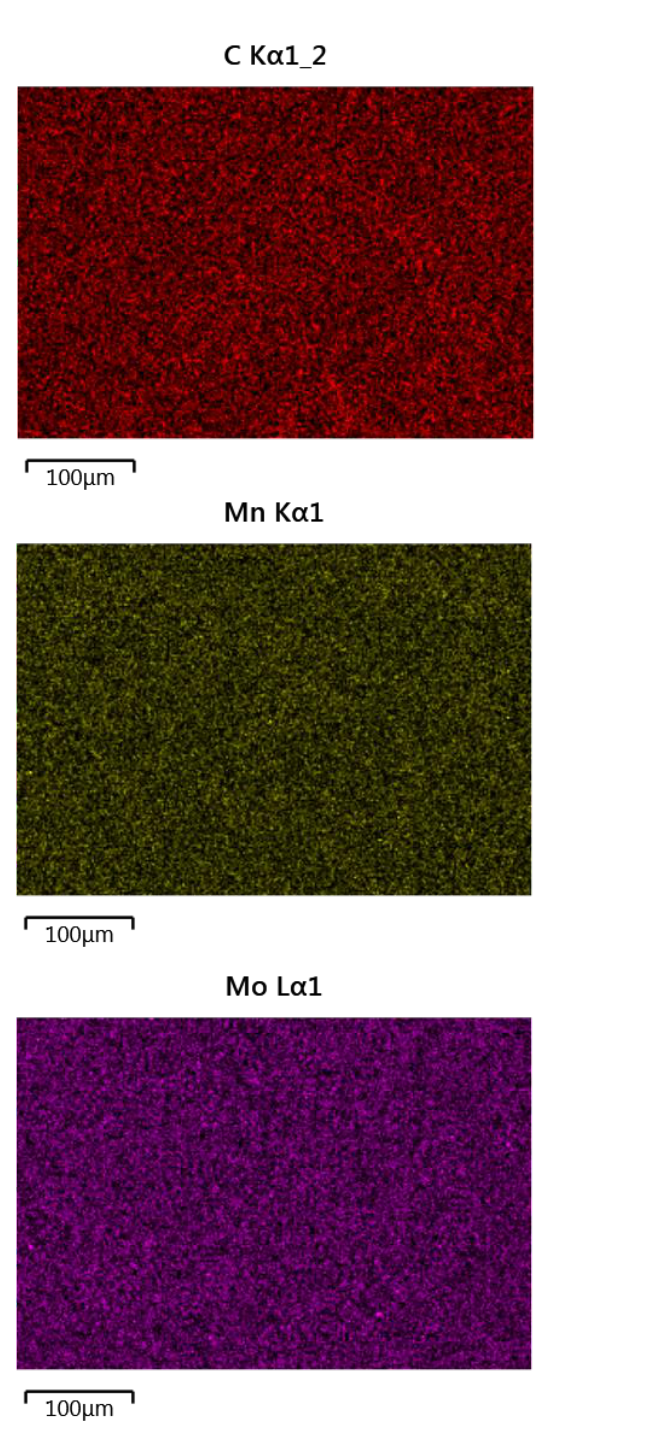
Figure 15. Surface element distributions in the HAZ1 subarea (shown in Figure 14) produced at 2400 W laser power.